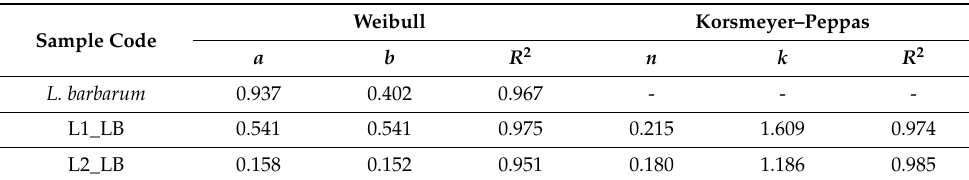
Table 2. Parameters of Weibull and Korsmeyer–Peppas models.